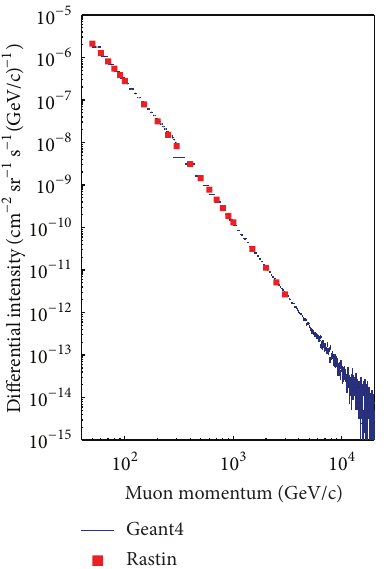
Figure 1: Sea level muon distribution: measurements by Rastin [13] and primary muons used in Geant4 simulation (color